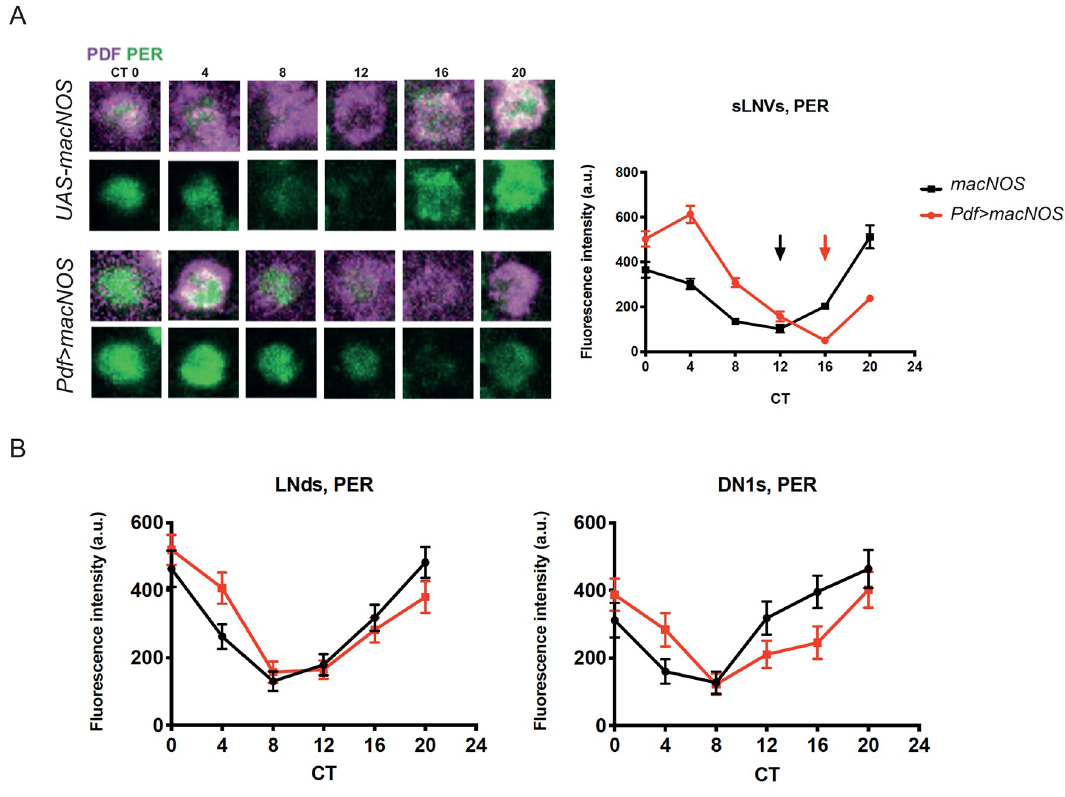
Fig 5. Hyperproduction of NO delays PER rhythms in the s-LNvs. PER in the brains of PDF > macNOS and control flies carrying only UAS-macNOS were monitored every 4 h on DD3 by immunostaining with anti-PER and anti-PDF antibodies. (A) Representative confocal images of the s-LNvs (left) and PER levels in the s-LNvs (right). (B) PER levels in DN1s and LNds. Mean ± SEM. Red and black arrows in (A) point at the trough of PER rhythms in Pdf > macNOS and control flies, respectively. PER rhythms in the s-LNvs are delayed by approximately 4 h in PDF > macNOS